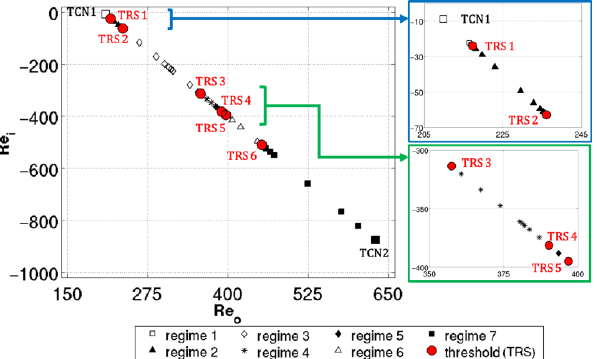
Figure 12. Map of flow regimes and thresholds between them observed passing from TCN1 to TCN2.